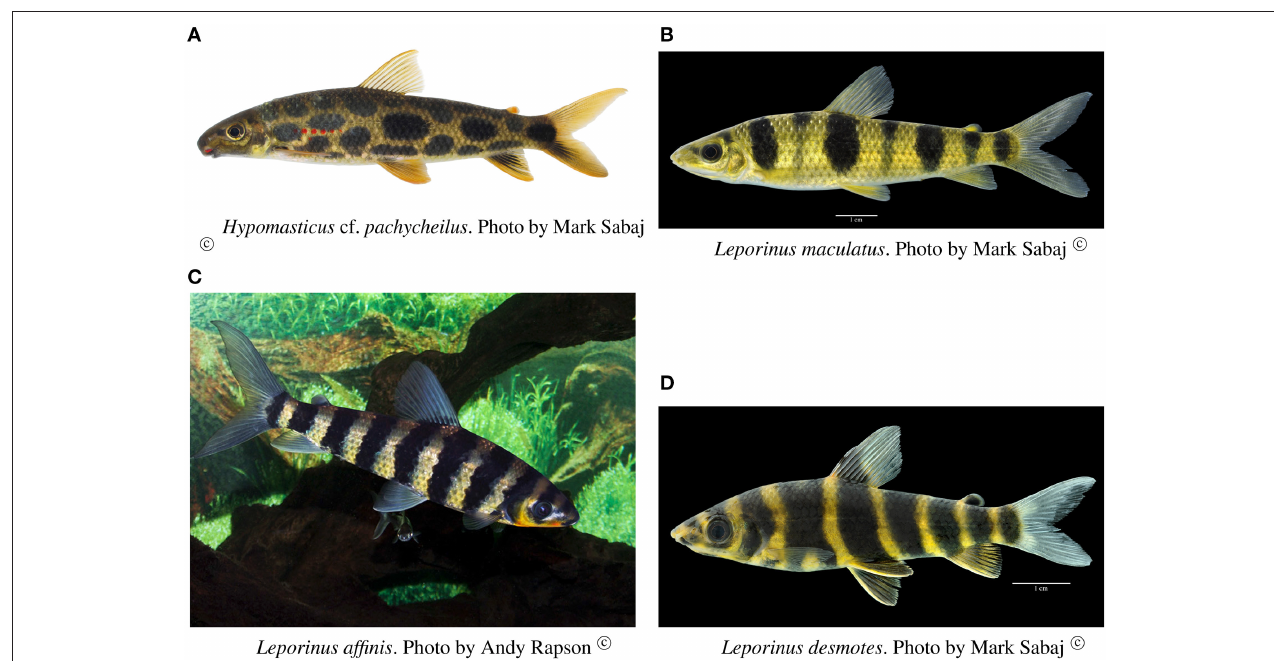
FIGURE 7 | Anostomid species analyzed in this